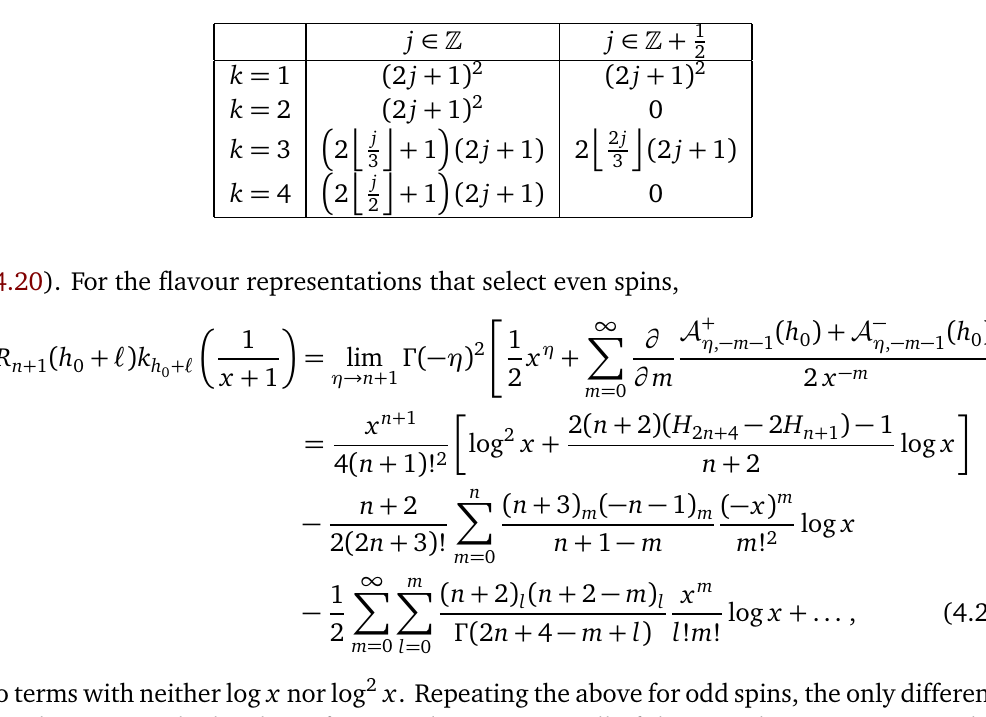
( n + 2 ) that enter in the double Table 5: S-fold values of the coefficients b ( n , j ) / R − 2 j − 2 discontinuity. They follow from (4.11), (4.12), (4.13) and (4.14) after stripping off the factors which this subsection has absorbed into the sum over spins. Note